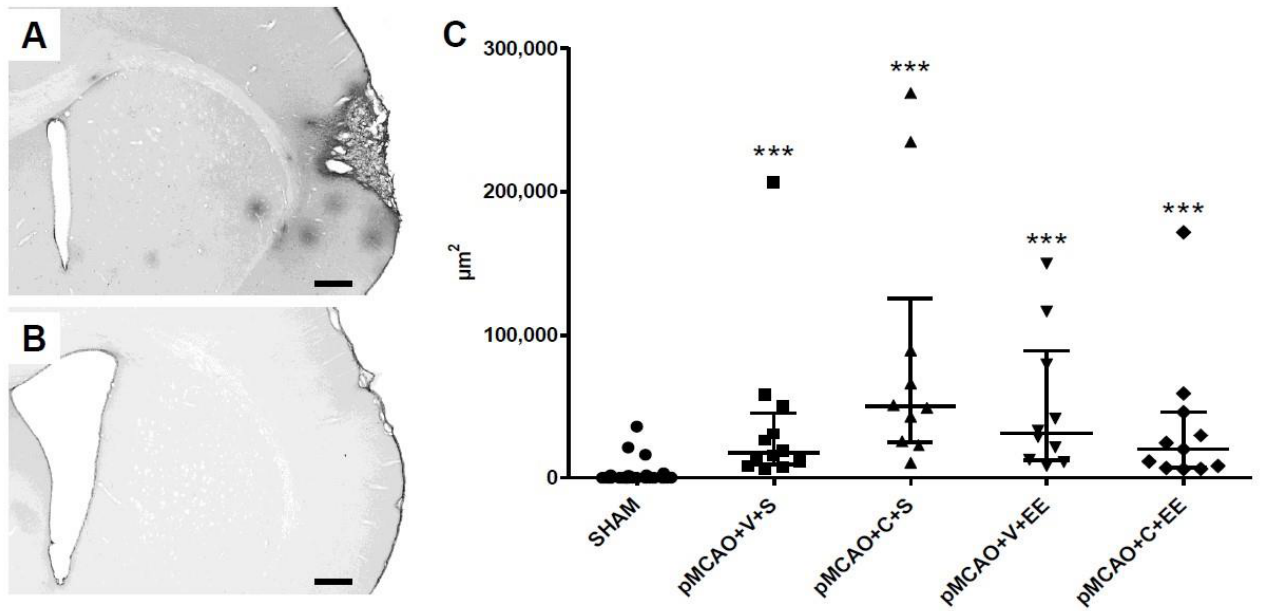
Figure 5. ImageJ/Fiji quantification of blood–brain barrier (BBB) leakage. Representative immunoglobulin G (IgG)-stained sections of pMCAO ( A ) and SHAM ( B ) animals. There was an ischemia-induced increase in the area of IgG staining in the perilesional cortex ( C ). Statistical significance: *** p < 0.001 (compared to the pooled SHAM group) (Kruskal–Wallis H test followed by Mann–Whitney U test corrected for multiple comparisons). Data are expressed as median with IQR. SHAM = sham-operated; pMCAO = permanent middle cerebral artery occlusion; V = 48 h vehicle administration; C = 48 h cell administration; S = standard housing; EE = enriched environment. Scale bar 500 µm ( A , B ).